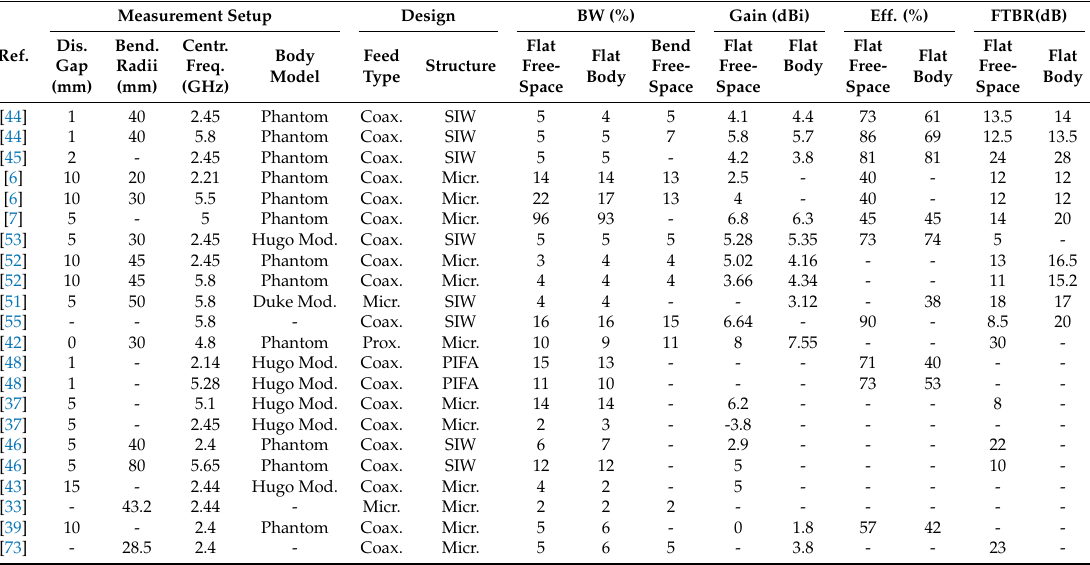
Table 3. Antenna Measurements under Diverse